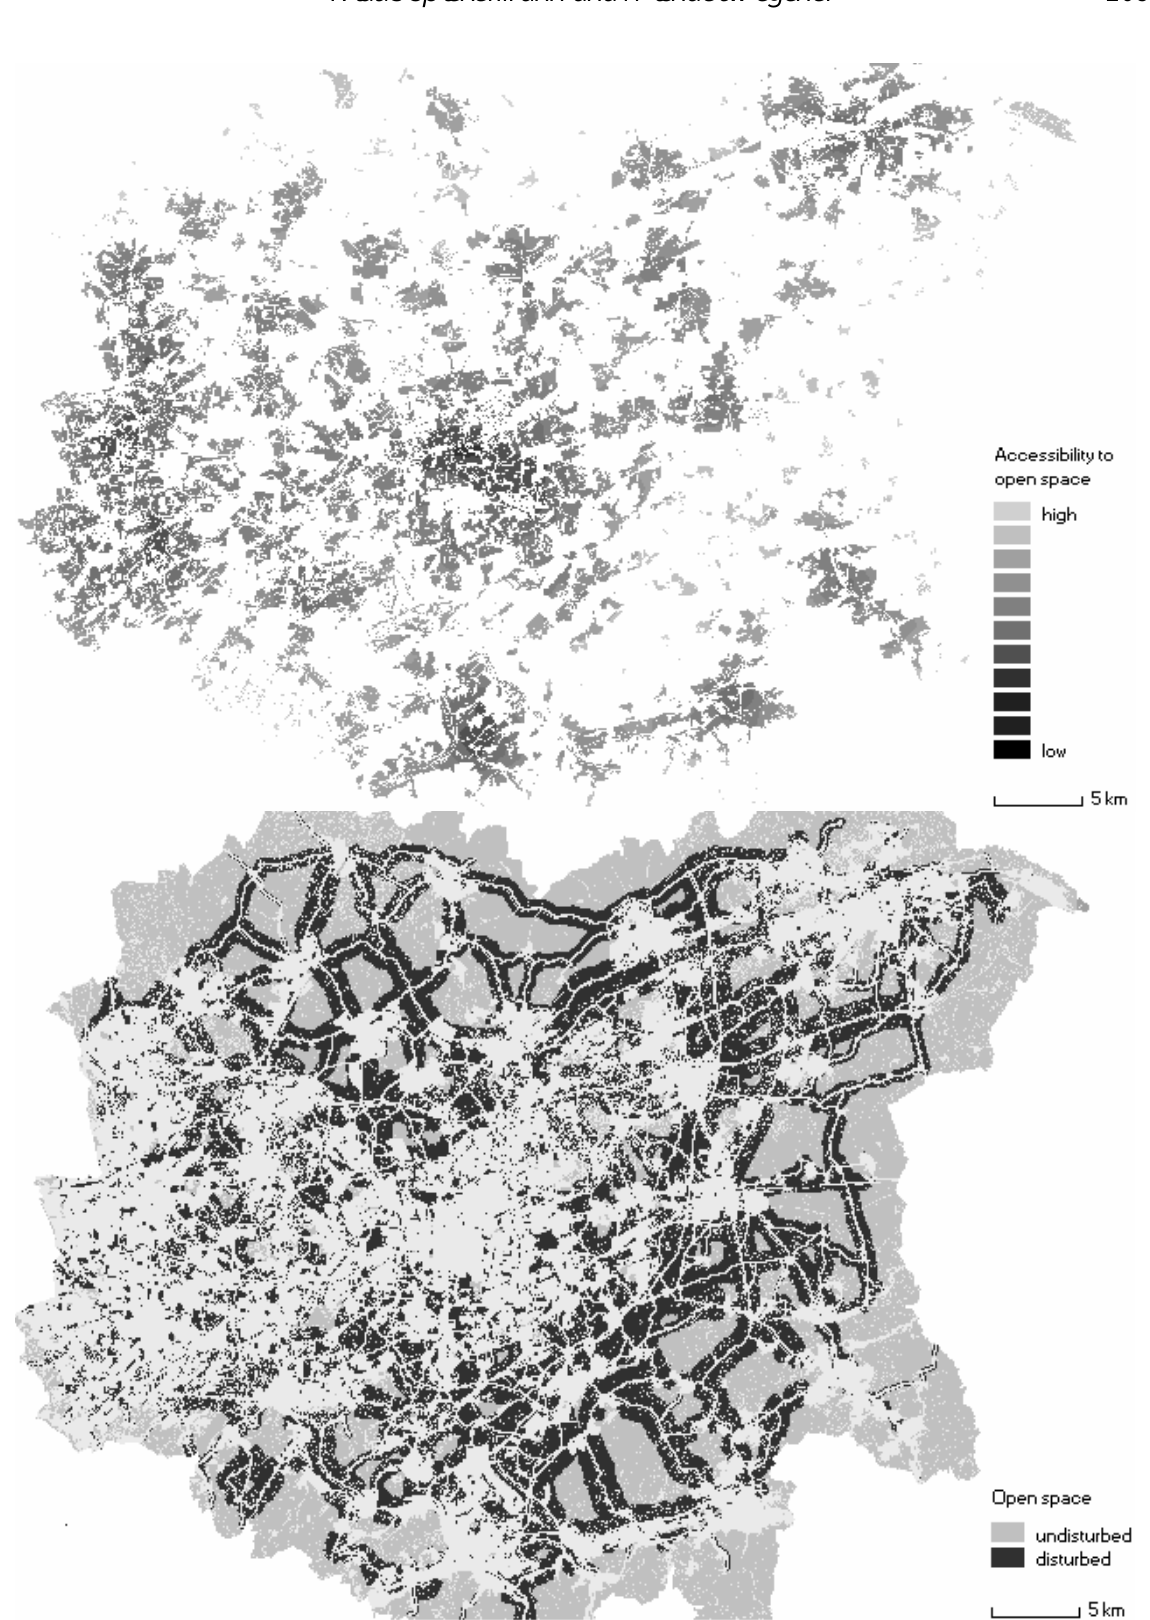
Figure 5. Quality of open space (top) and accessibility to open space (bottom) in the Dortmund